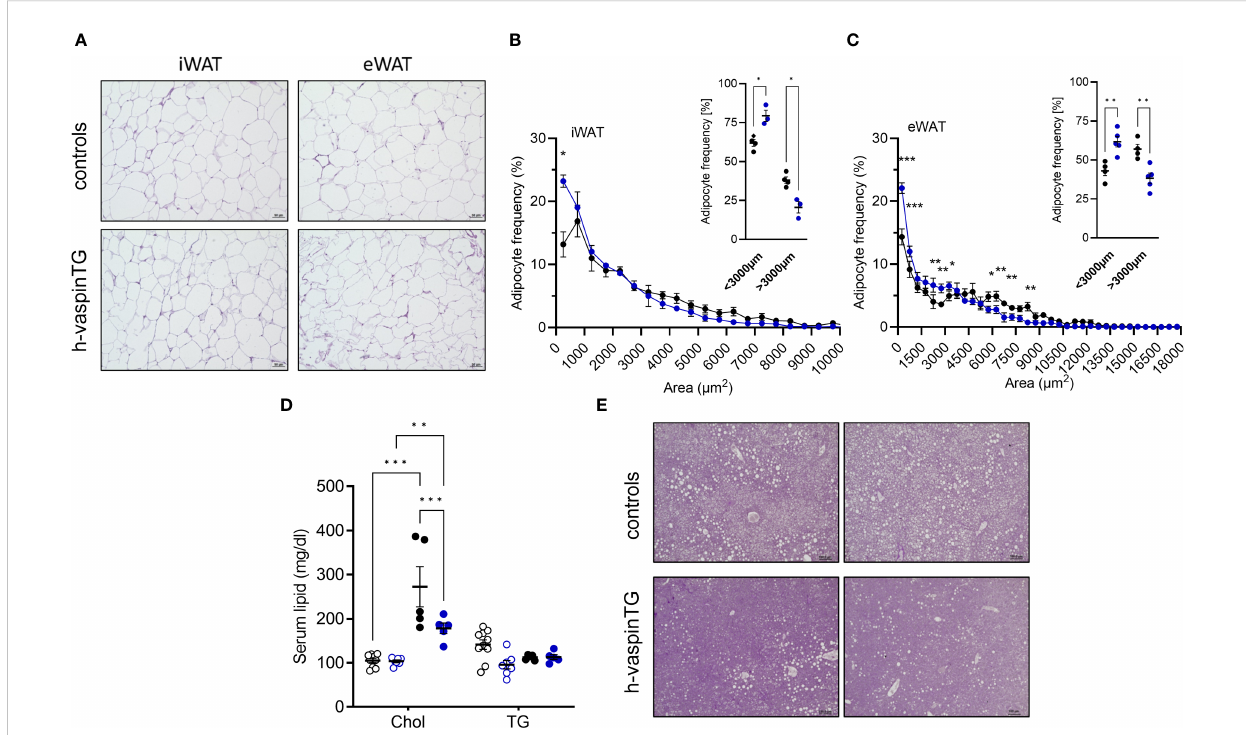
FIGURE 2 h-vaspinTG mice exhibit less hypertrophy in white adipose tissue (AT) and reduced fatty liver under high fat diet (HFD). (A) Representative histological H&E stained sections of inguinal (iWAT) and epididymal (eWAT) adipose tissue of HFD fed h-vaspinTG and control mice. Scale bar: 50 µm. (B, C) Adipocyte size distribution in iWAT (B) and eWAT (C) sections (n = 3-5 per group). (D) Cholesterol (Chol) and serum triglycerides (TG) (mg/dl) were measured in chow and HFD-fed h-vaspinTG and control mice. (E) Two representative histological PAS stained liver sections of HFD- fed h-vaspinTG and control mice. Scale bar: 100 µm. (F) Liver glycogen levels (µg) of chow and HFD-fed h-vaspinTG and control mice. (n = 5-10 per group). Data are presented as mean ± SEM. Statistical signi fi cance was calculated by multiple t-tests (B, C) or two-way ANOVA followed by Tukey ’ s post-hoc test (D) (*p ≤ 0.05, ** p ≤ 0.01, ***p ≤